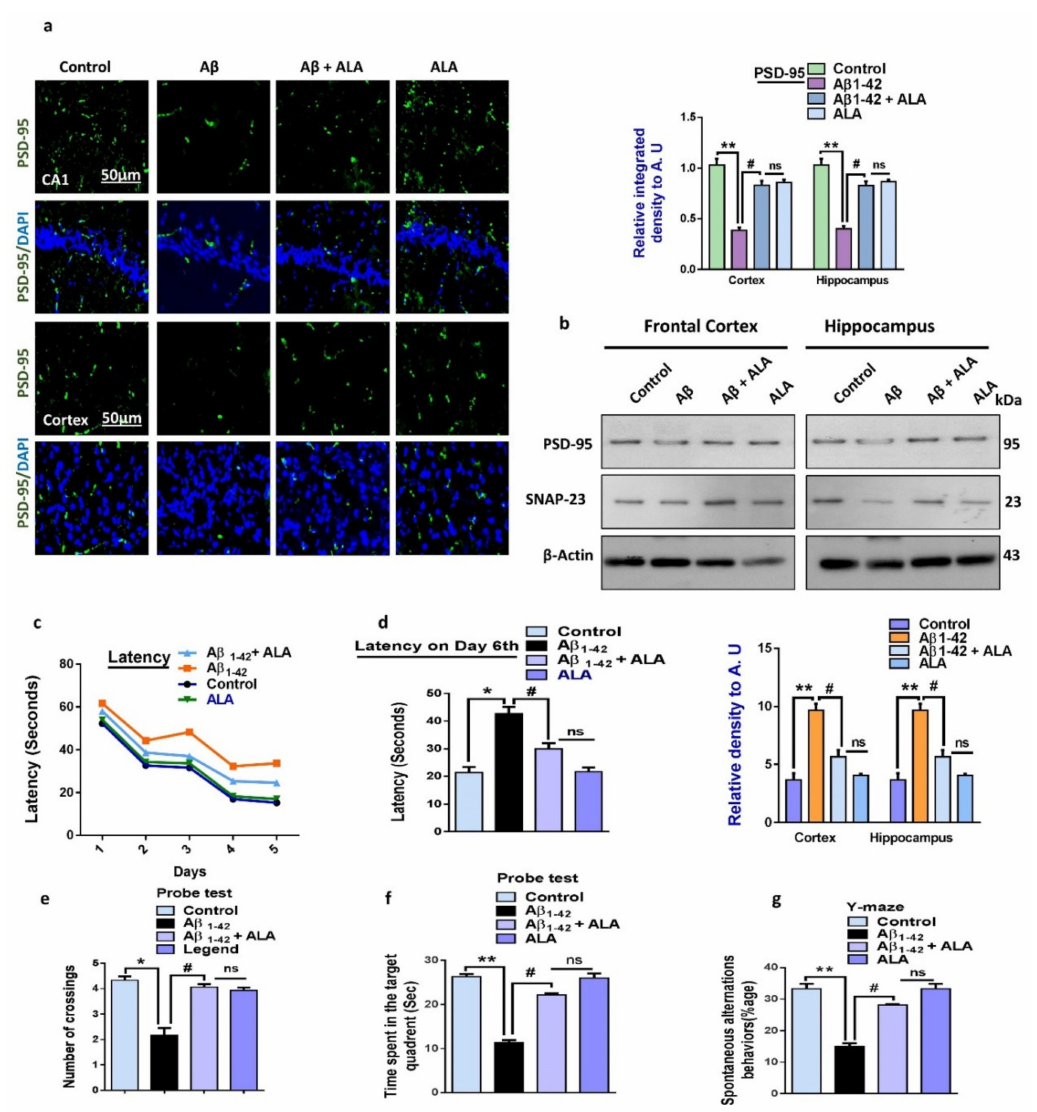
Figure 5. E ff ects of alpha linoleic acid against A β -induced synaptic and memory dysfunctions in mice. ( a ) Immunofluorescence results of PSD-95 in the frontal cortices and hippocampi of the experimental groups ( n = 10 mice per group) with respective bar graphs. Magnification: 30 × ; scale bar: 50 µ m. ( b ) Immunoblot results of PSD-95 and SNAP-23 in the frontal cortices and hippocampi (CA1) of the treated mice groups ( n = 16 mice per group, 8 for IF and 8 for WB) with respective bar graphs. ( c ) Bar graph showing the mean time taken to escape (sec) during the training days. ( d ) Final escape time during the probe test. ( e ) Number of platform crossings. ( f ) Time spent in the target quadrant. ( g ) Spontaneous alternation behavior. * Significantly di ff erent from the A β -treated group; # significantly di ff erent from the A β + ALA-cotreated group. Significance = * p < 0.05; * * p < 0.01; # p < 0.05; and ## p < 0.01. A β : amyloid beta; ALA: alpha linoleic acid; DAPI: 4 (cid:48) ,6-diamidino-2-phenylindole; ns = non